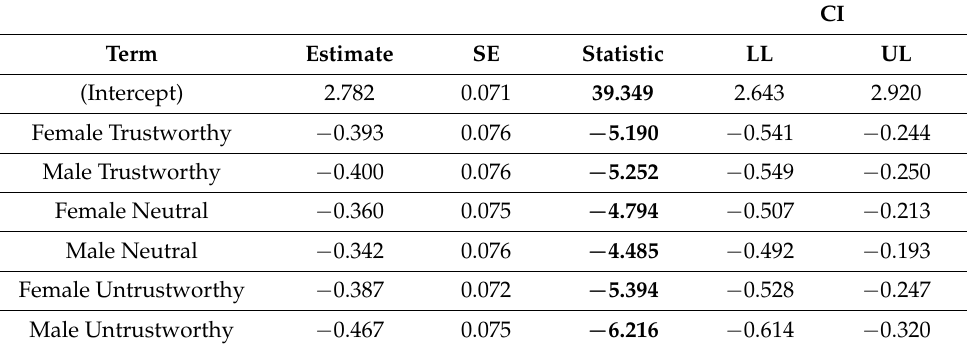
Table 7. Coefficient of glmm on response times. Each coefficient is a contrast between the baseline and the condition. CI = 95%. LL = lower level. UP = upper level. Significant statistics ( t as z criterion) are reported in bold.